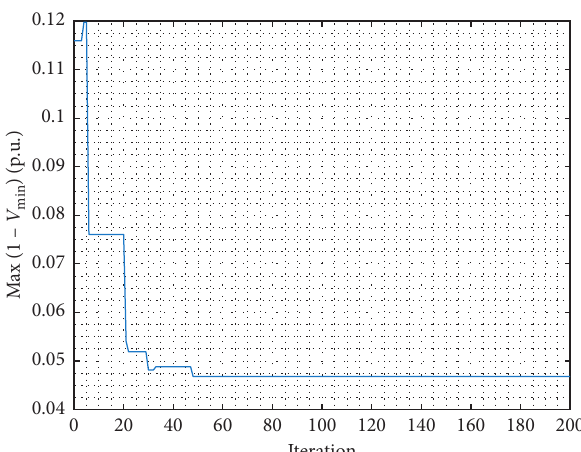
Figure 7: The convergence characteristic of voltage deviation for the 84-bus system.